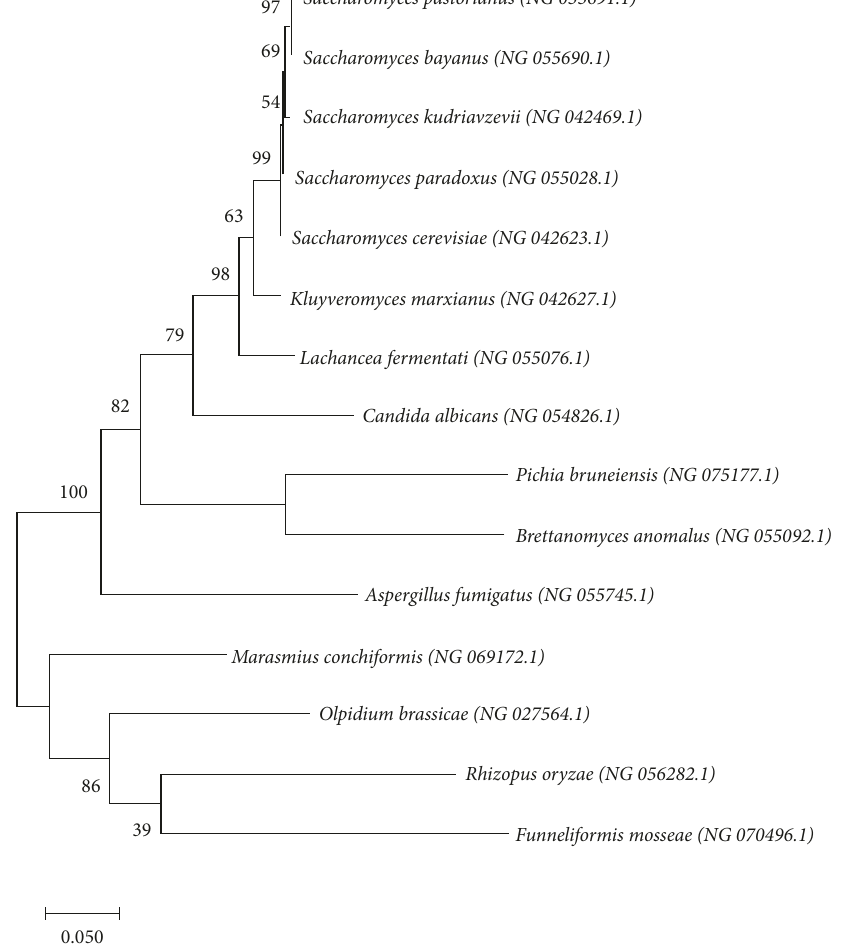
Figure 1: Phylogenetic tree constructed using the 28s rDNA sequences. Sequences are labeled with their database accession numbers. Support values are from Bayesian inference, and maximum likelihood analyses (values above and below the branches, respectively) were conducted in MEGA X software (molecular evolutionary genetics analysis: